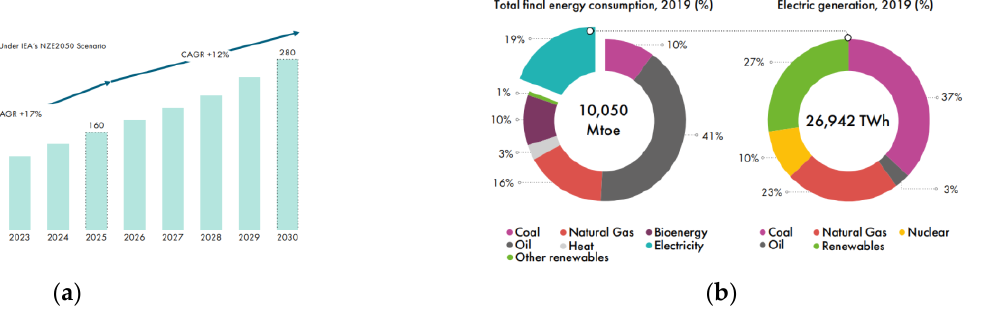
Figure 1. Wind power overview. ( a ) New global wind installations (GW) (GWEC-Global-Wind-Report-2021) * Source: GWEC Market Intelligence; IEA World Energy Outlook (2020), volume in 2022–2024 and 2026–2029 are estimates; ( b ) global final energy consumption (GWEC-Global-Wind-Report-2021).